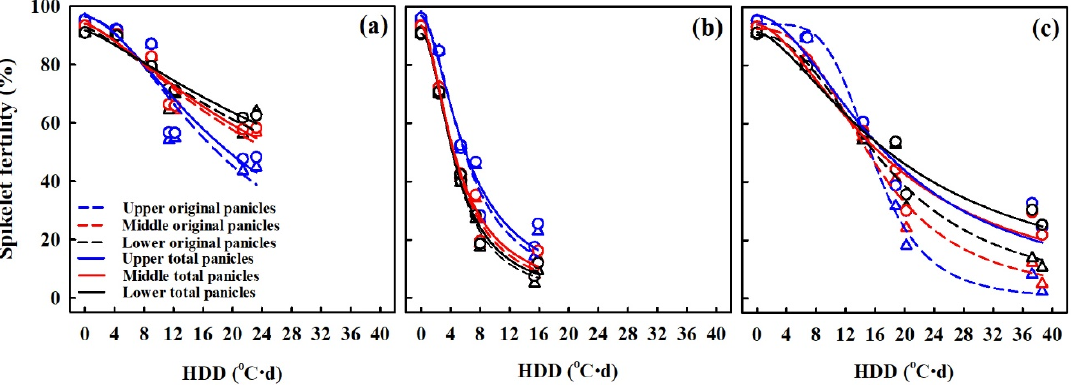
Figure 7. Observed and fitted spikelet fertility (%) of upper, middle, and lower parts of the panicles in relation to heat degree day (HDD) at three different growth stages of booting (BT) ( a ), flowering (FL) ( b ) and combined (BT + FL) stages ( c ). Both varieties were used in the graph ( τ was set to 33 °C for BT and 35 °C for FL. Total tillers ( ○ and solid line); original tillers ( △ and dashed line).